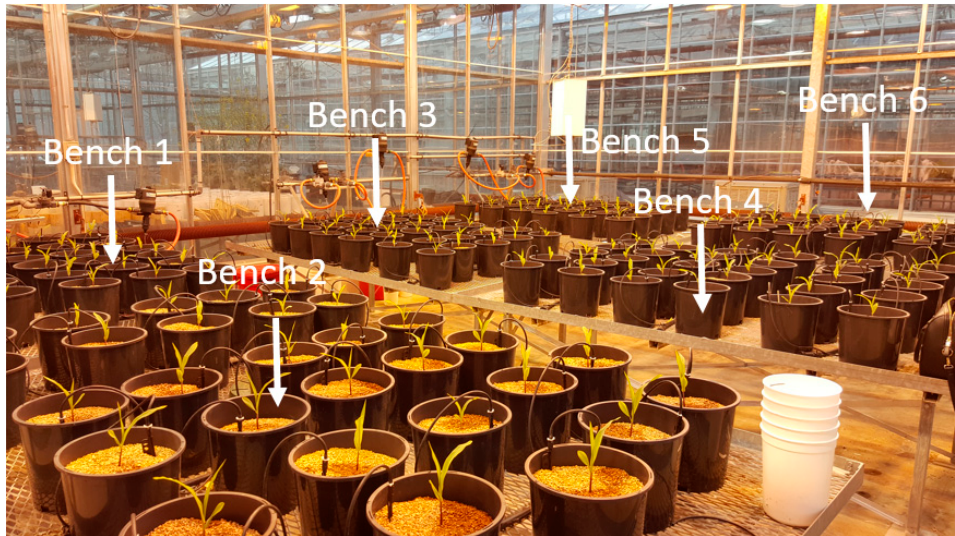
Figure 3. Greenhouse layout (this picture was taken on 5 November 2015).